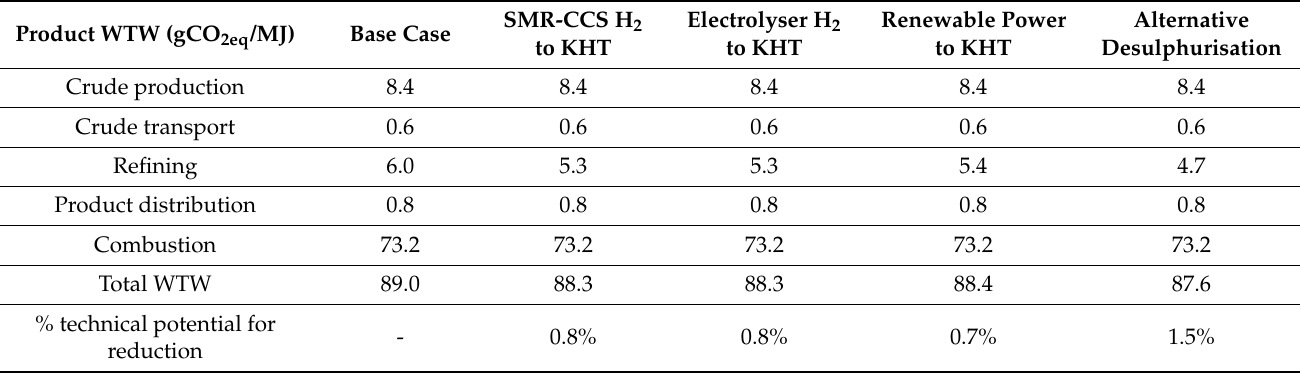
Table 6. Summary of the technical potential of jet fuel-specific GHG emission reduction